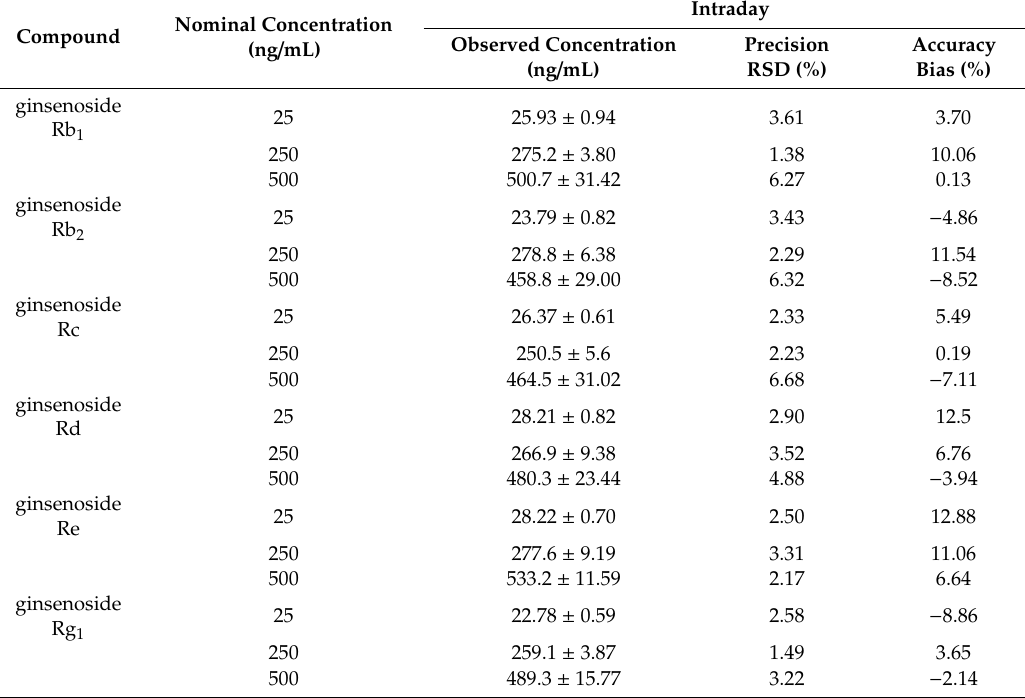
Table 1. Method validation of the intraday precision and accuracy for the ten determinations of ginsenosides from standard